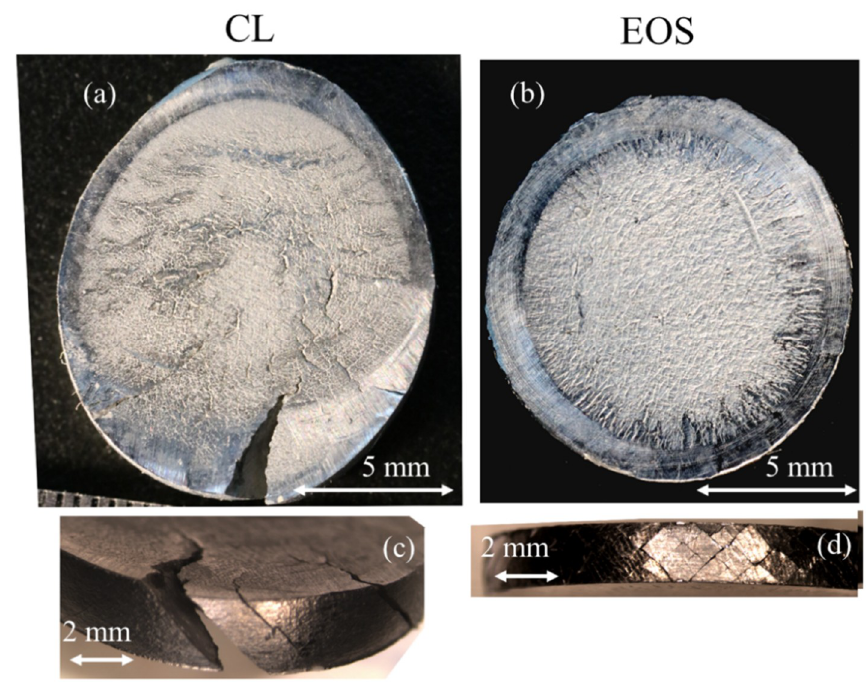
Figure 12. XY-oriented samples after SHPB tests at strain rate of 5800 to 6700 s − 1 , with plane view of samples for ( a ) CL and ( b ) EOS, and sample circumferences for ( c ) CL and ( d ) EOS.